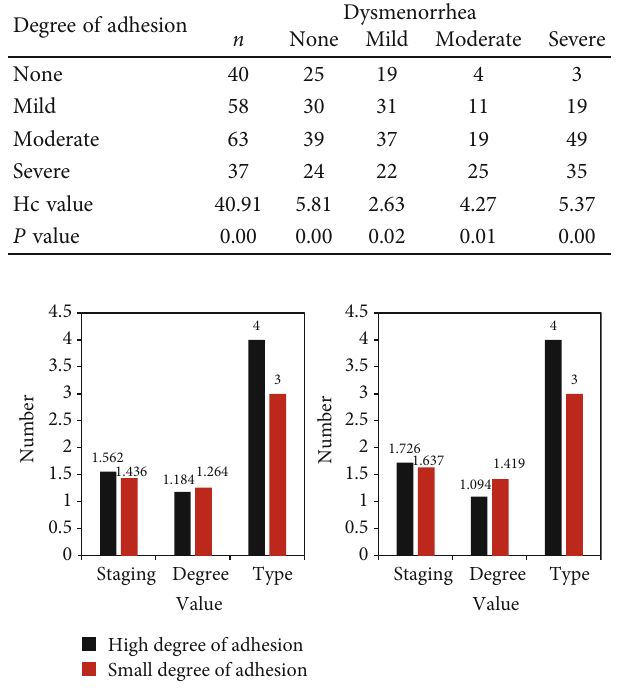
Figure 8: Correlation between pelvic adhesions and endometriosis.